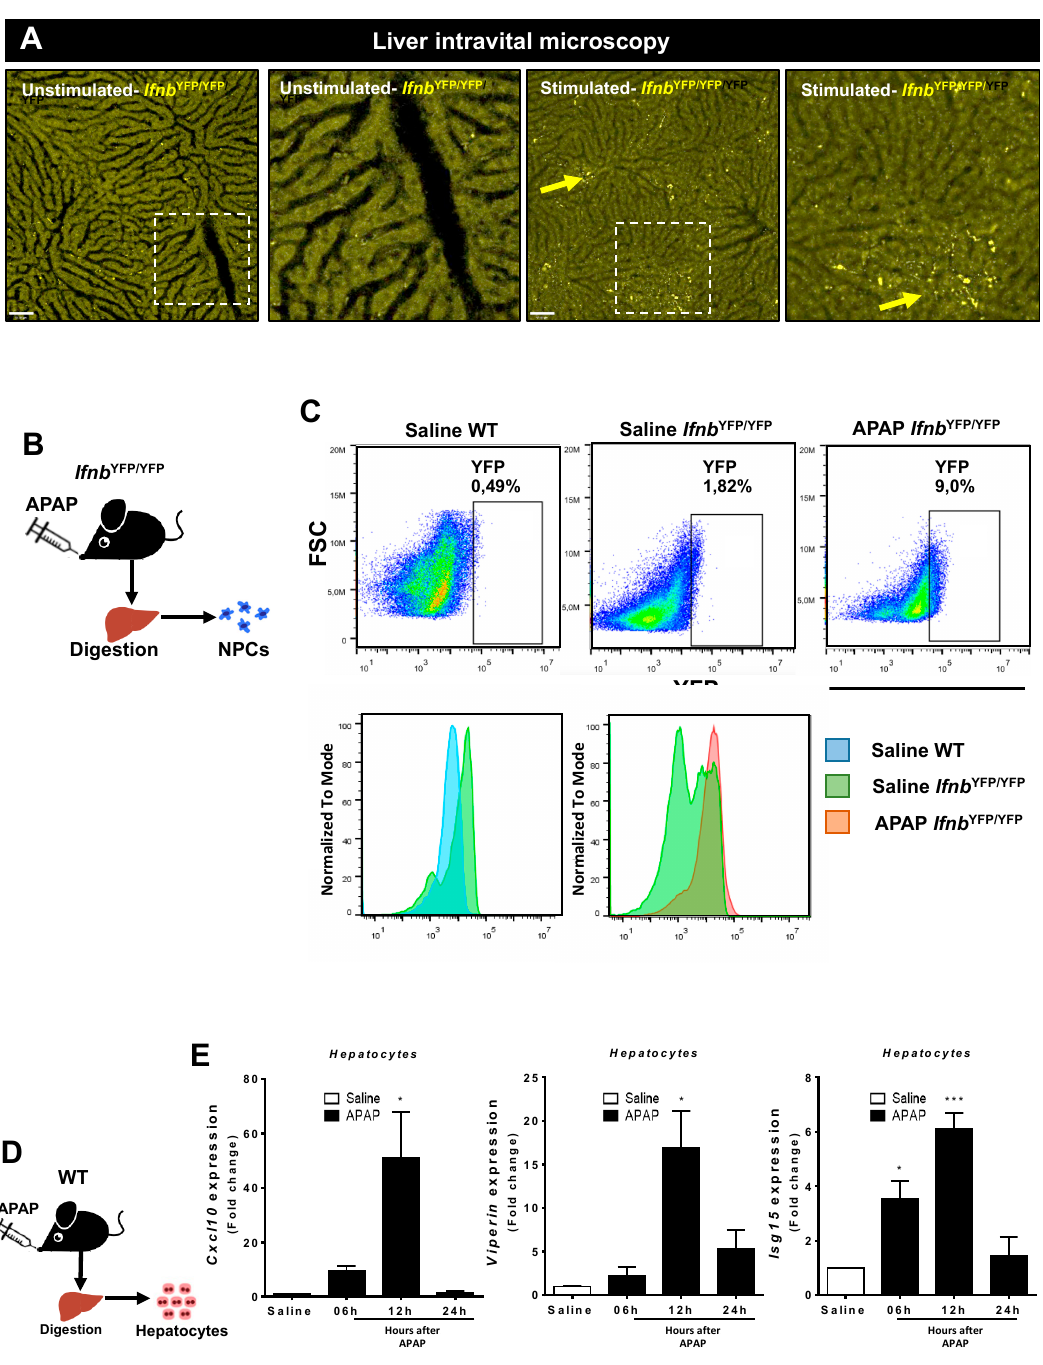
Figure 5. Interferon (IFN)-I production in liver during APAP injury. ( A ) Confocal intravital microscopy of IFN-beta reporter mouse (IFN YFP/YFP ) showing enhancement of IFN-beta expression upon stimulation in vivo. Scale bar = 60 µ m and inserts are derived from a 4 × magnification. Yellow arrows show spots of IFN-beta accumulation. ( B ) Scheme showing parenchymal cell isolation (hepatocytes) in mice treated with APAP (600 mg/kg). ( C ) Flow cytometry for the evaluation of IFN-I production by non-parenchymal liver cells in IFN YFP/YFP mice. ( D ) Scheme showing the non-parenchymal cell isolation from IFN YFP/YFP mice 12 h after treatment with APAP (600 mg/kg). ( E ) Evaluation of IFN-I-regulated gene expression in hepatocytes after hepatic injury induction; the relative expression was done using the control (saline) hepatocytes as a reference. (Mean ± SEM; n = 4); * p ≤ 0.05 and *** p ≤ 0.001 compared to control hepatocytes.